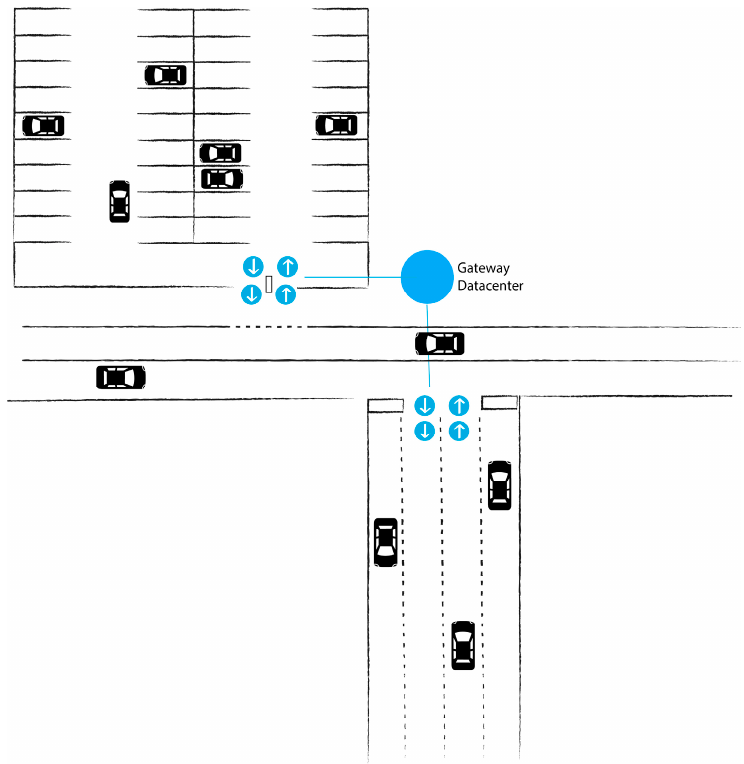
Figure 1. System architecture in a closed car park and on a public road.